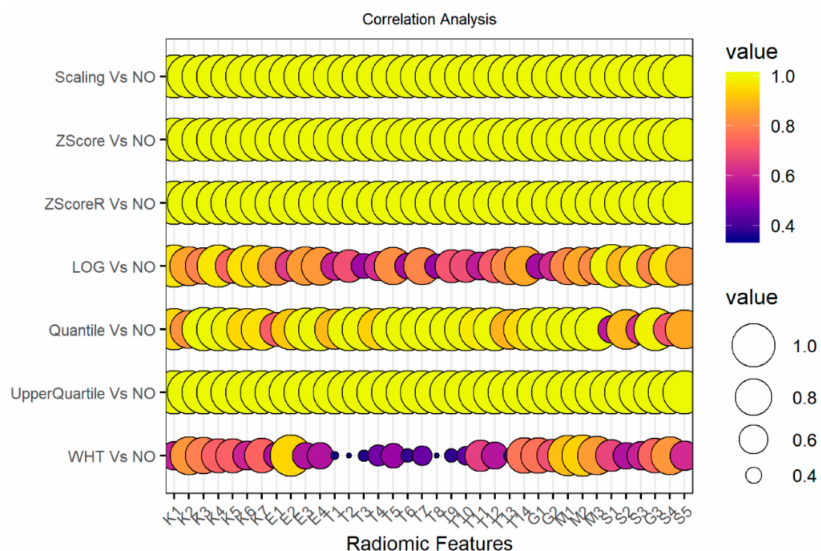
Figure 2. Correlation analysis on the whole dataset between non-normalized and normalized radiomic features. On the x-axis radiomic features are reported; on the y-axis correlation coe ffi cients via Spearman correlation analysis are reported for each comparison between normalization methods and raw features (i.e., non-normalized radiomic features). All correlation p-values resulted less than 0.05. NO: non-normalized features; Scaling normalization method; Z-score normalization method; ZscoreR: Robust Z-score normalization method; LOG transformation; Quantile and Upper Quartile normalization method; WHT: Whitening normalization